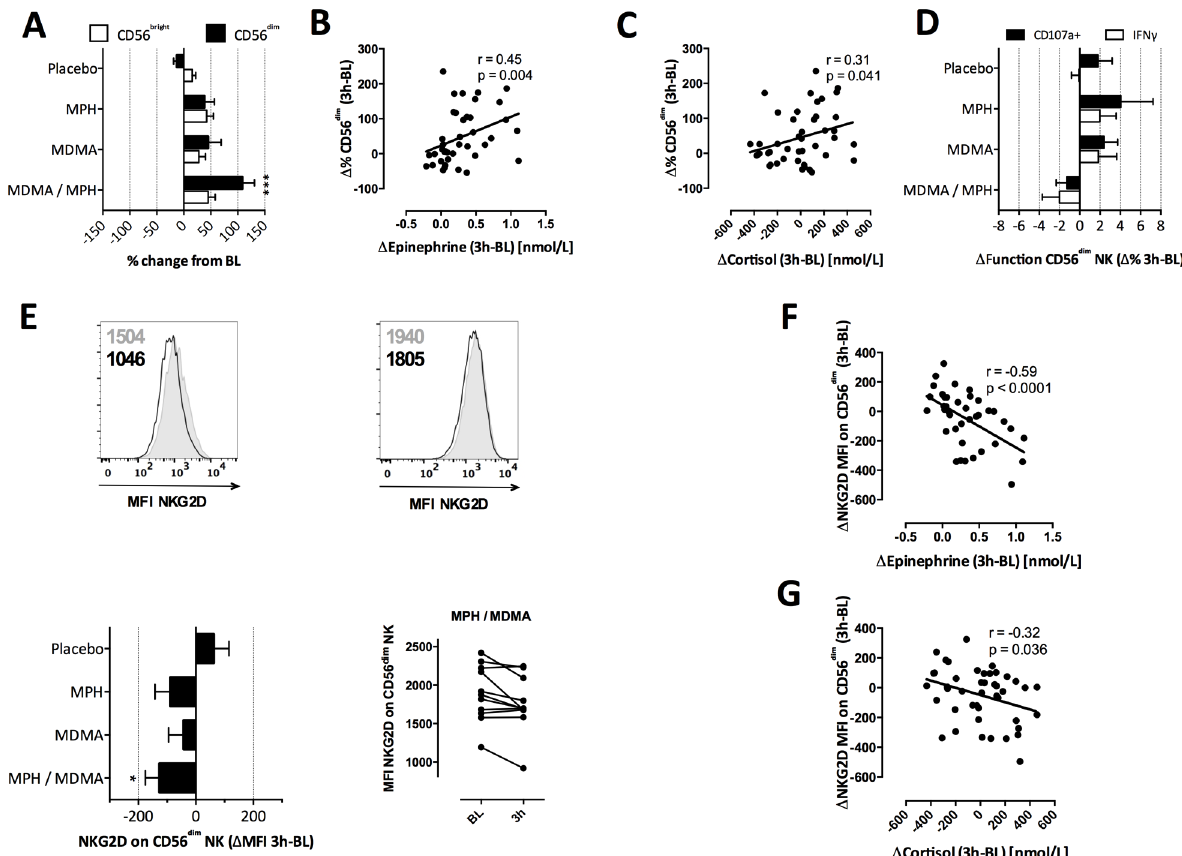
Fig 2. Unaltered NK function but reduced NKG2D expression upon drug-induced stress. (A) Percent change in the two NK cell subsets was calculated and expressed as mean + S.E.M. (B,C) The percent change of CD3 - CD56 dim NK cells was correlated to the change in serum epinephrine (B) and cortisol (C) levels 2 hours p.a. in all drug categories together (n = 44). (D) NK function against K562 target cells was assessed. Changes in IFN γ + or CD107a + (degranulation) CD56 dim NK cells are shown for each drug category as absolute change in percentage (n = 11, mean + S.E.M). (E) Example histograms of NKG2D MFI before (grey) and after (black) MPH / MDMA treatment are shown for a donor with a strong (left) and weak (right) response (upper panels). The numbers indicate the MFI. Absolute change in the MFI of NKG2D expression (n = 12, mean + S.E.M) is displayed for each drug condition (lower left panel). NKG2D MFI at baseline and 3 hours p.a. is shown separately for all subjects for the condition with a significant difference to placebo (MPH / MDMA) (lower right panel). The absolute change in MFI of NKG2D was correlated to serum epinephrine (F) and cortisol (G) levels irrespective of drug treatment (n = 44). Spearman correlation and nonlinear fit were applied for correlation analyses and Kruskal-Wallis test was applied for all group comparisons. * P < 0.05, ** P < 0.01, *** P < 0.001.